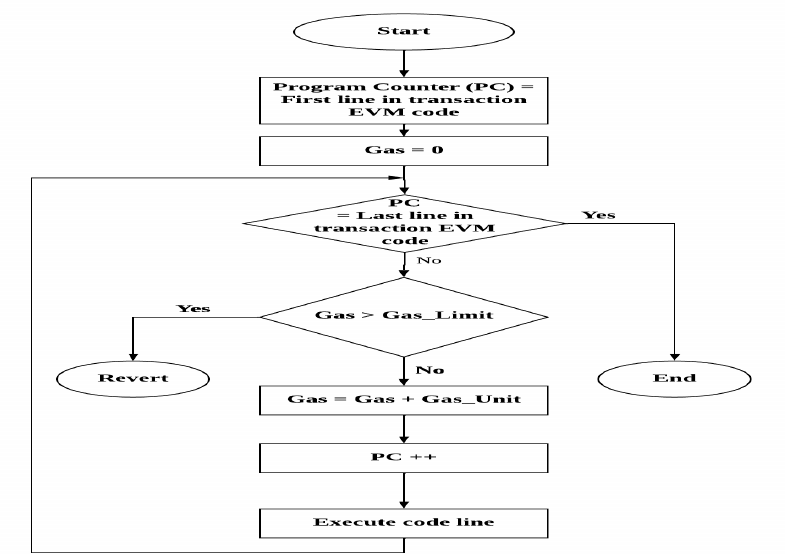
Figure 5. Gas consumption for Ethereum transaction execution.